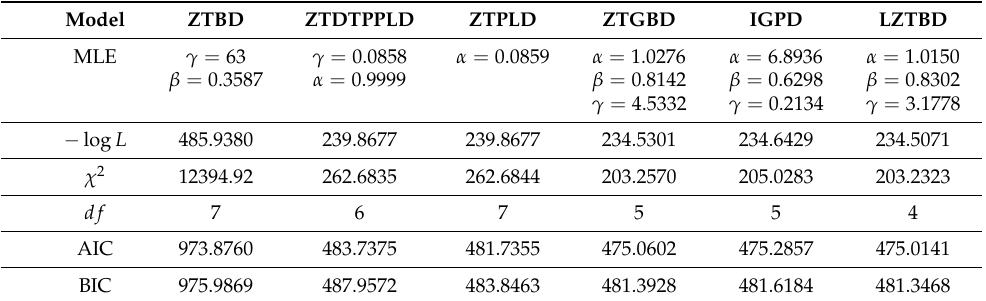
Table 4. Maximum likelihood estimates (MLEs), model adequacy measures and χ 2 values for the COVID-19 data set of Italy.